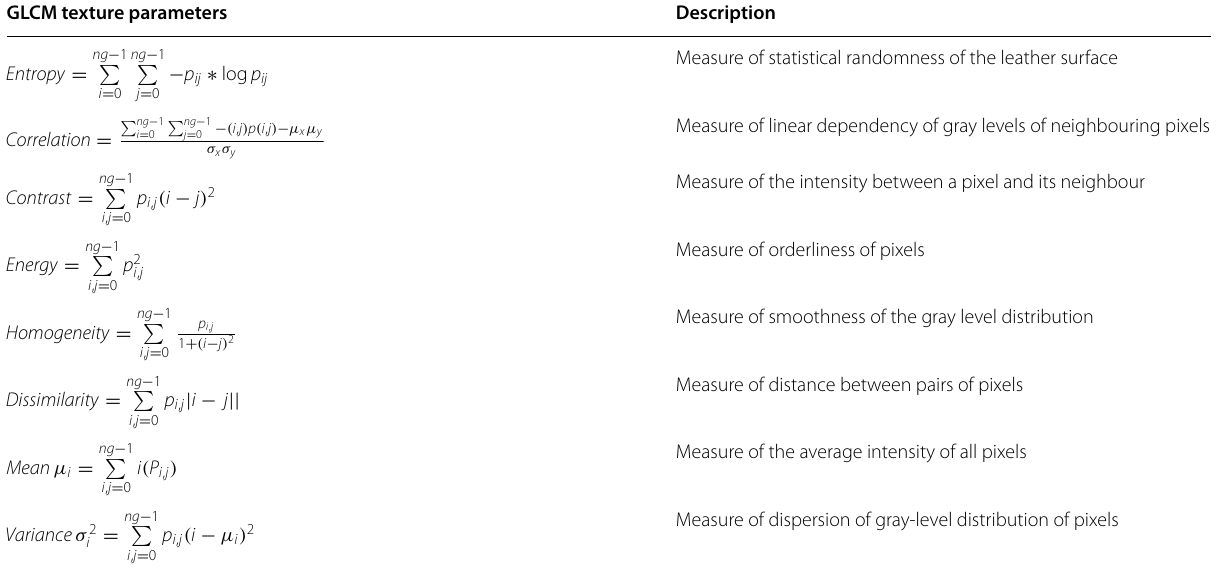
Table 2 Description of GLCM texture features used for leather defect identification [10] GLCM texture parameters